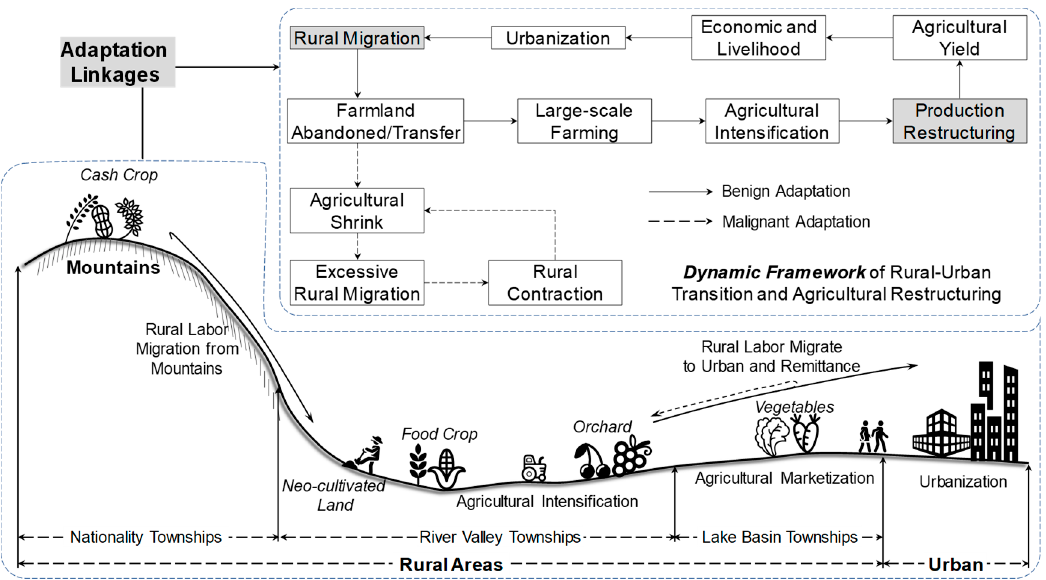
Figure 12. The adaptation linkages of rural–urban transitions and agricultural restructuring.